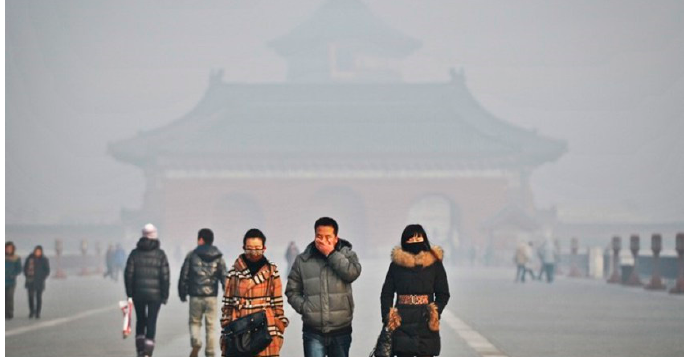
Figure 4. Photochemical smog appearing on January 2016 in Beijing, China. Reproduced from https://i1.wp.com/dnnsociety.org/wp-content/uploads/2016/01/beijing.jpg?resize=845%2C450&ssl=1 (accessed 10 November 2018).